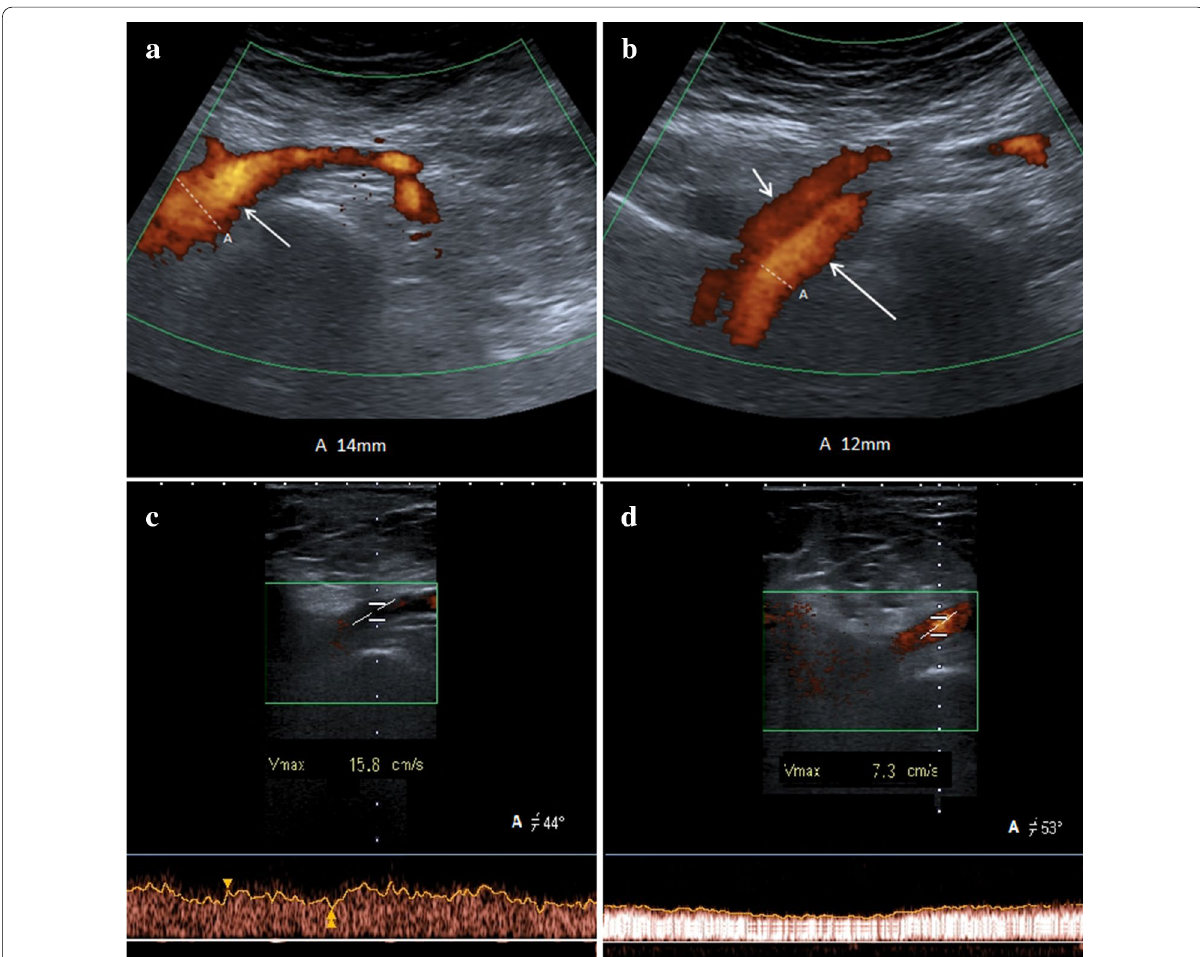
Fig. 12 Power Doppler US and Duplex Doppler US of common iliac veins. a Left common iliac vein (arrow) dilatation in the pre-stenotic tract (14 mm). b Right common iliac vein (long arrow) with regular diameter (12 mm). Right common iliac artery (short arrow). c Duplex Doppler US shows a regular peak speed in the post-stenotic tract of the left common iliac vein (15.8 cm/s) and peak speed reduction in the pre-stenotic tract (7.3 cm/s)